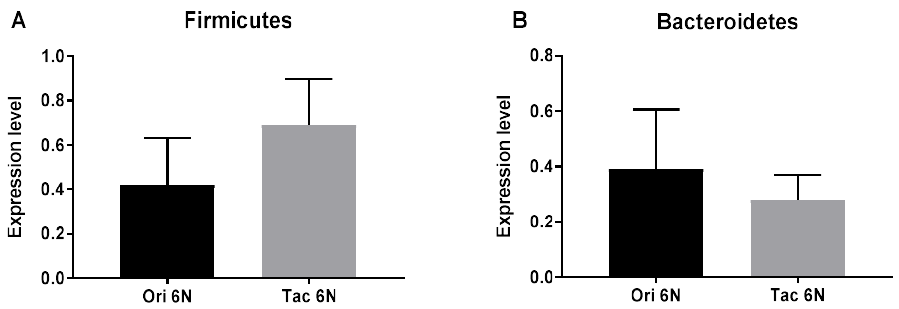
Figure 2. Differences in the microbiota composition of substrains of C57BL/6 mice at the onset of the experiment. The initial microbiota composition of C57BL/6NCrljOri (Ori 6N) and C57BL/6NTac (Tac